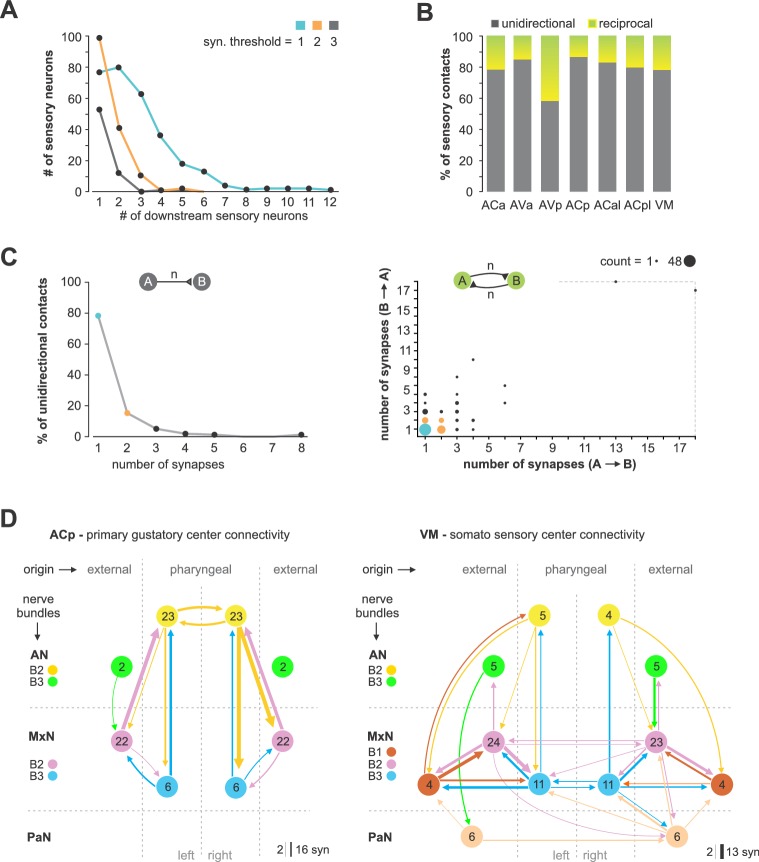
Connectivity principles of inter-sensory connections.(A) Amount of monosynaptic downstream partners (sensory neurons) per sensory neuron, using a synaptic threshold of 1–3 synapses. (B) Percentage of neurons per sensory compartment showing hierarchical or reciprocal inter sensory connections. Most of the sensory neurons are connected in a hierarchical manner. (C) Percentage of all unidirectional connections across all sensory clusters in relation to synaptic strength between two sensory neurons (left panel). Amount of reciprocal connection combinations between two sensory neurons (right panel). (D) Connectivity graph of all inter-sensory contacts of ACp and VM neurons using a synaptic threshold of 2. Sensory information with different peripheral origin (nerves, organs) is integrated at the sensory level. Node numbers indicate amount of sensory neurons.